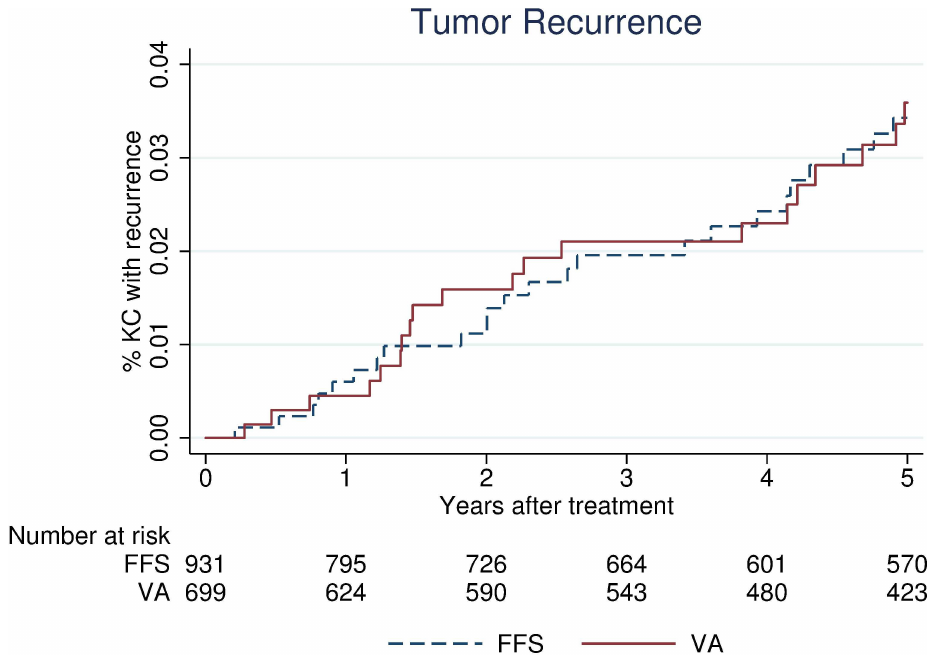
Fig 2. Clinical Outcome Measure, Kaplan-Meier failure curve for tumor recurrence. Abbreviations: VeteransAffairs (VA), fee-for-service(FFS),